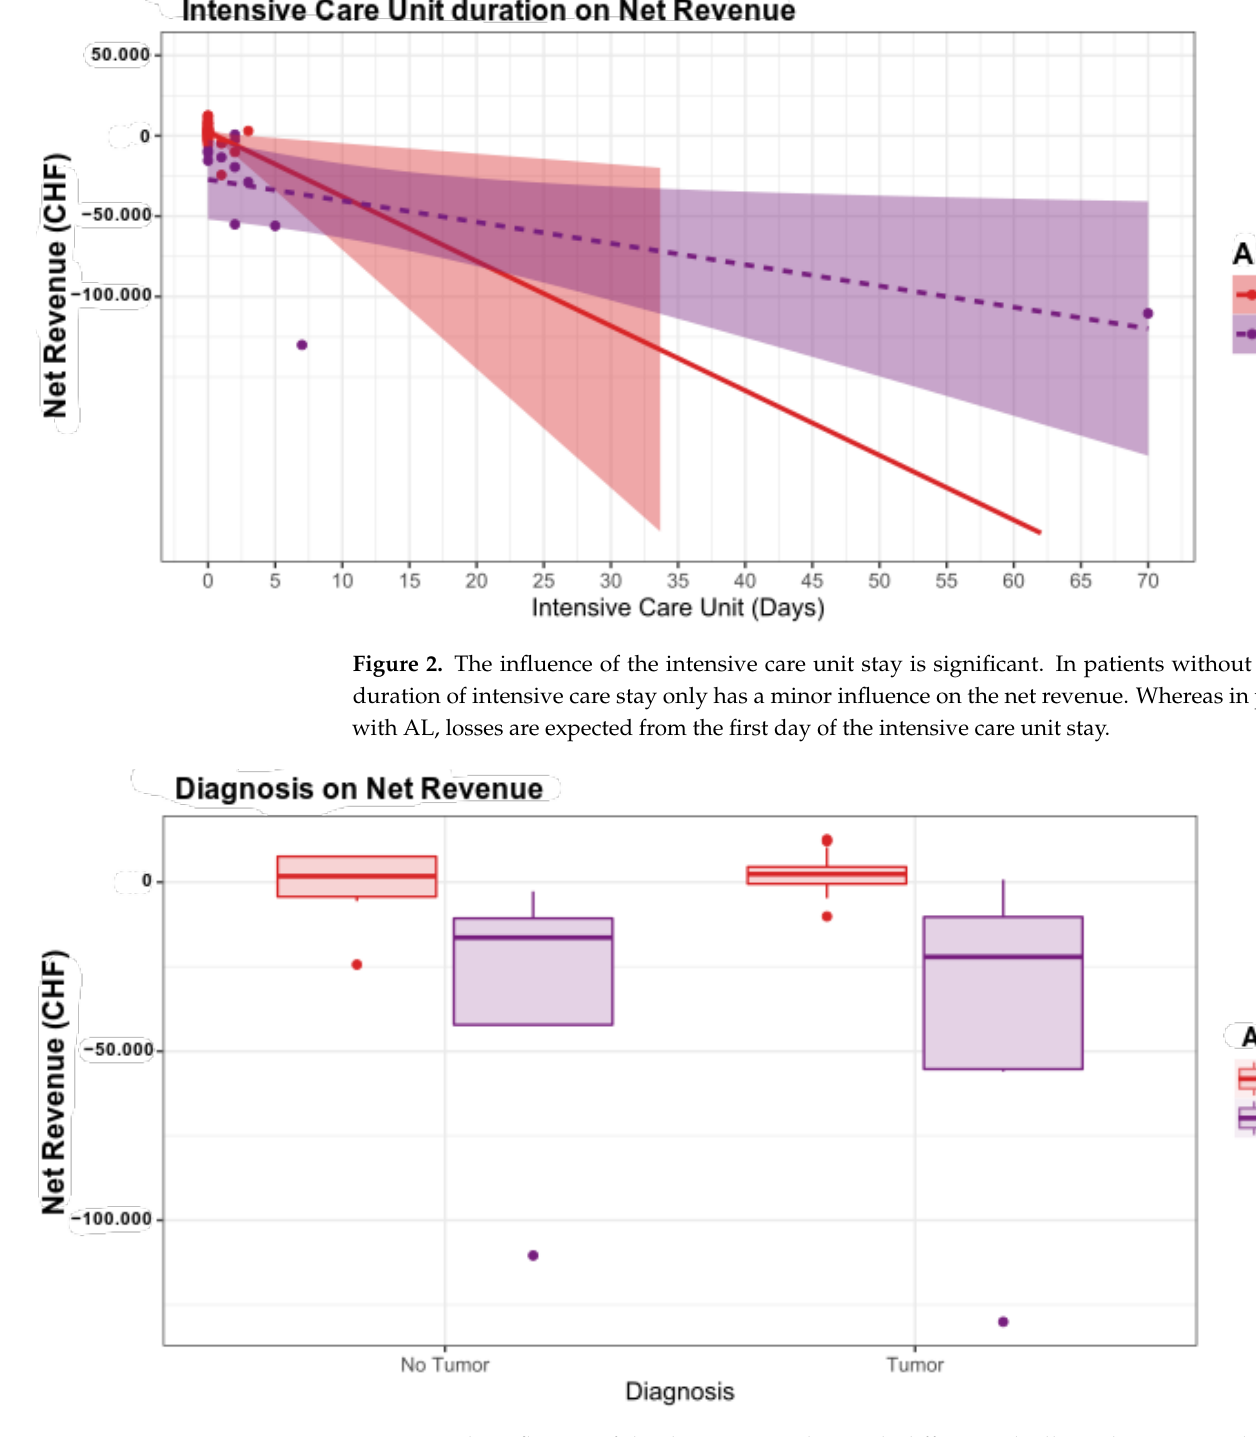
Figure 3. The influence of the diagnosis on the result differs markedly in the two populations of patients without and those with AL. For patients without AL, the type of diagnosis only has a minor influence on the net revenue. 1, No Tumor; 2, Tumor.